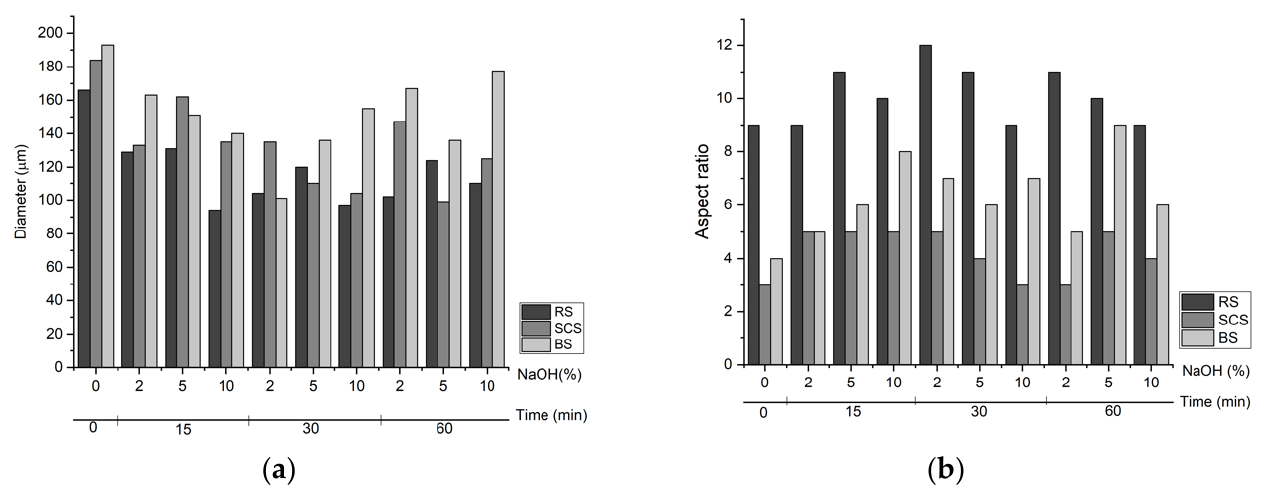
Figure 3. ( a , b ) Diameter aspect ratio of untreated and treated RS, SCS, and BS fibers.